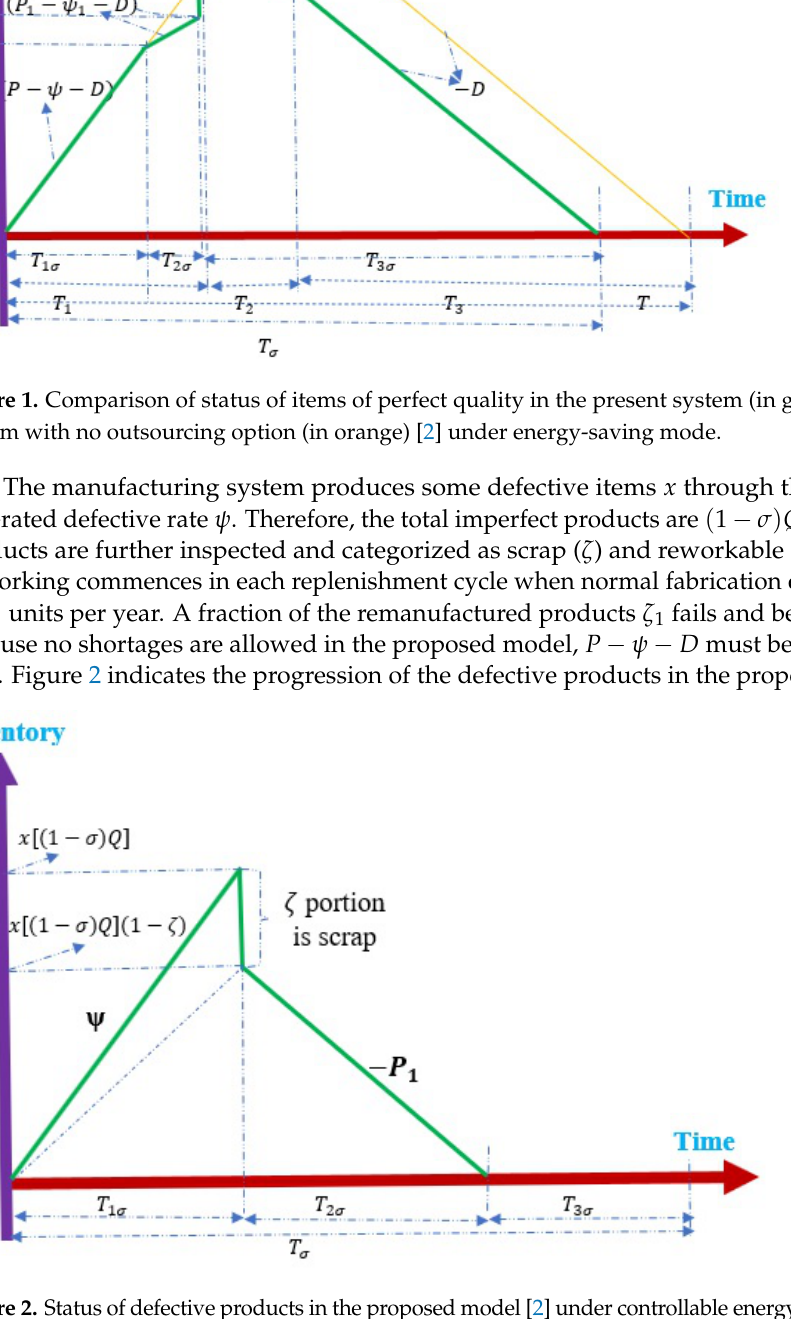
Figure 2. Status of defective products in the proposed model [2] under controllable energy